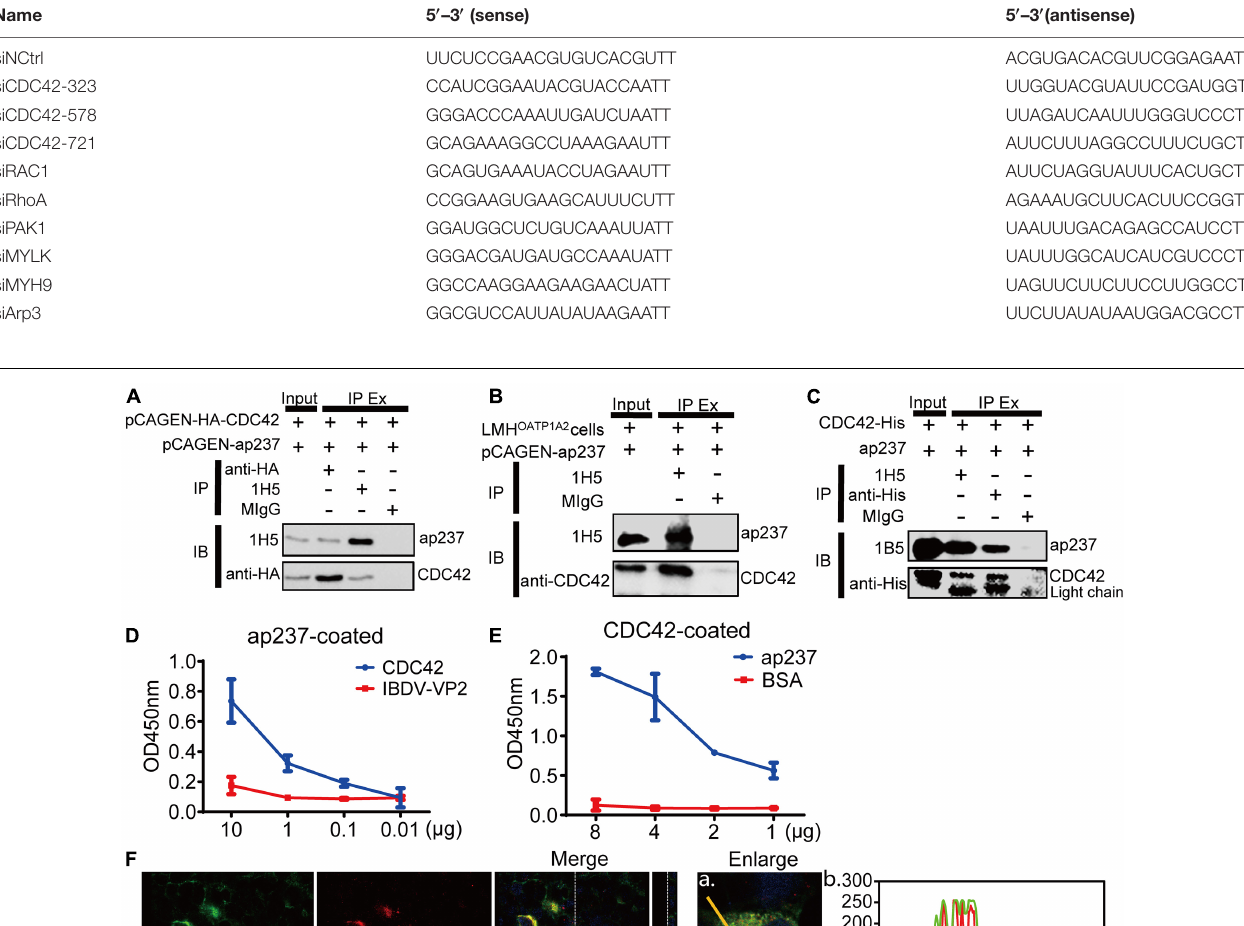
TABLE 2 | The siRNA targeting CDC42 in this study.